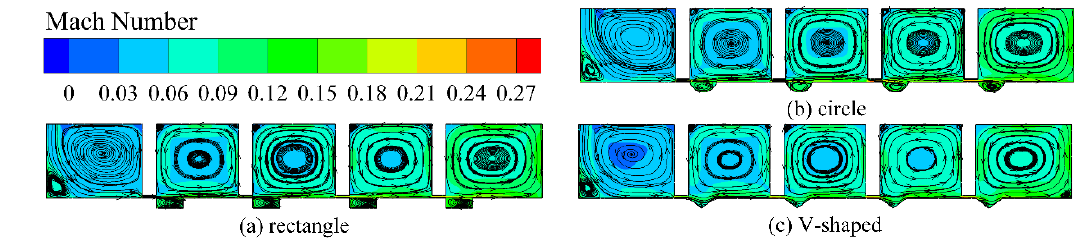
Figure 11. The Mach number contours of meridional plane of leakage passage on stator1.